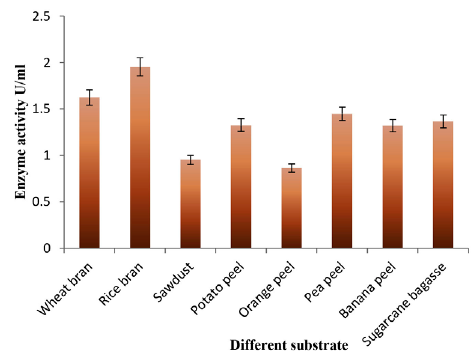
Fig. 3. Screening of agro wastes for laccase production studies were carried out using rice bran as an effective substrate for enzyme production in SmF. From this, it is evaluated that the agro wastes reduce the disposal problem and prevent probable environmental pollution.